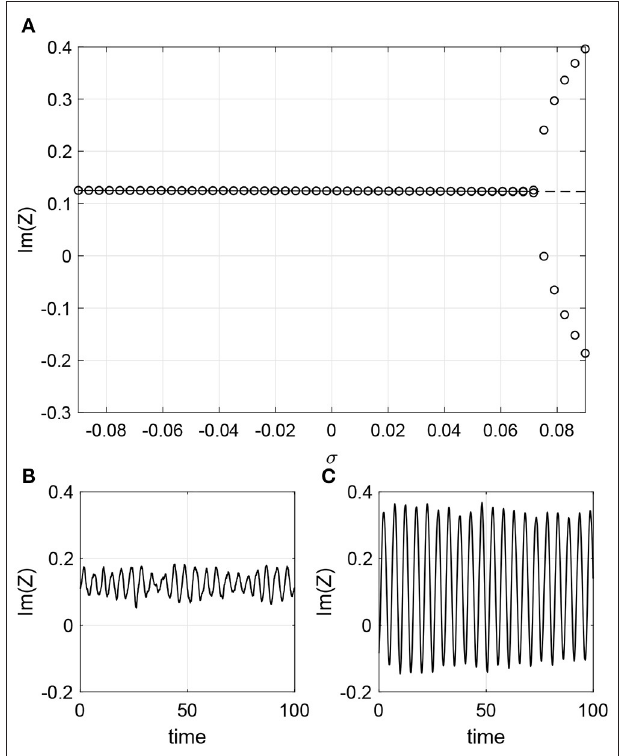
σ ˆ k in . (A) Solid line: 0.09 = +